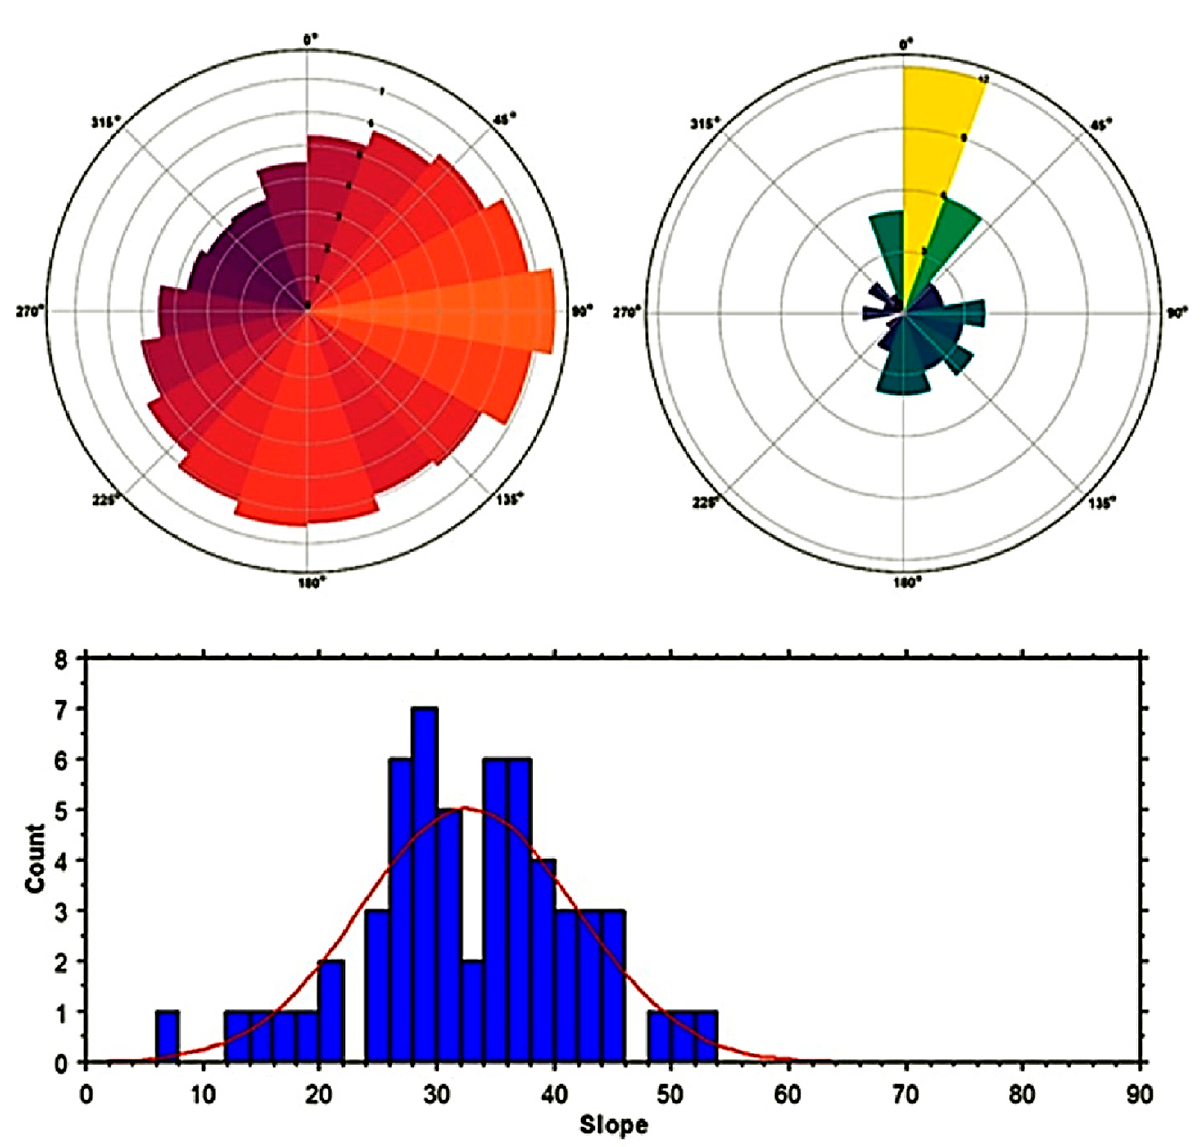
Figure 9. Upper left : percent of LS study area in different aspects. Flat (no aspect) surfaces that occur in Indian Wells Valley have been removed. Upper right : number of recorded rockfall features in each 20 ◦ aspect class for the Ridgecrest event. Bottom : distribution of mapped rockfall features by slope (degrees) of the centroid of the mapped unit.